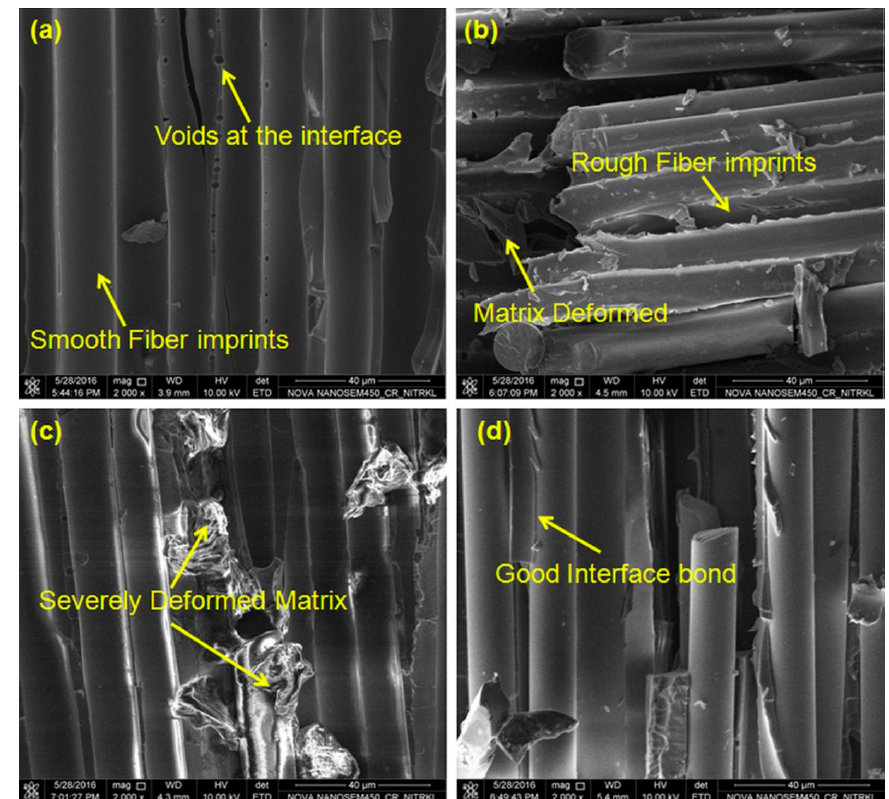
Figure 6. Field Emission scanning Electron Microscopy (FESEM) images of fractured surface of hydrothermally conditioned samples having different wt % of nano-Al 2 O 3 : ( a ) 0.0; ( b ) 0.1; ( c ) 0.3; ( d ) 0.7 [67]. Reprinted by permission from Springer Nature: Springer, Polymer Bulletin 74: 4175–4194, Water absorption, residual mechanical and thermal properties of hydrothermally Bankim Chandra Ray, Copyright